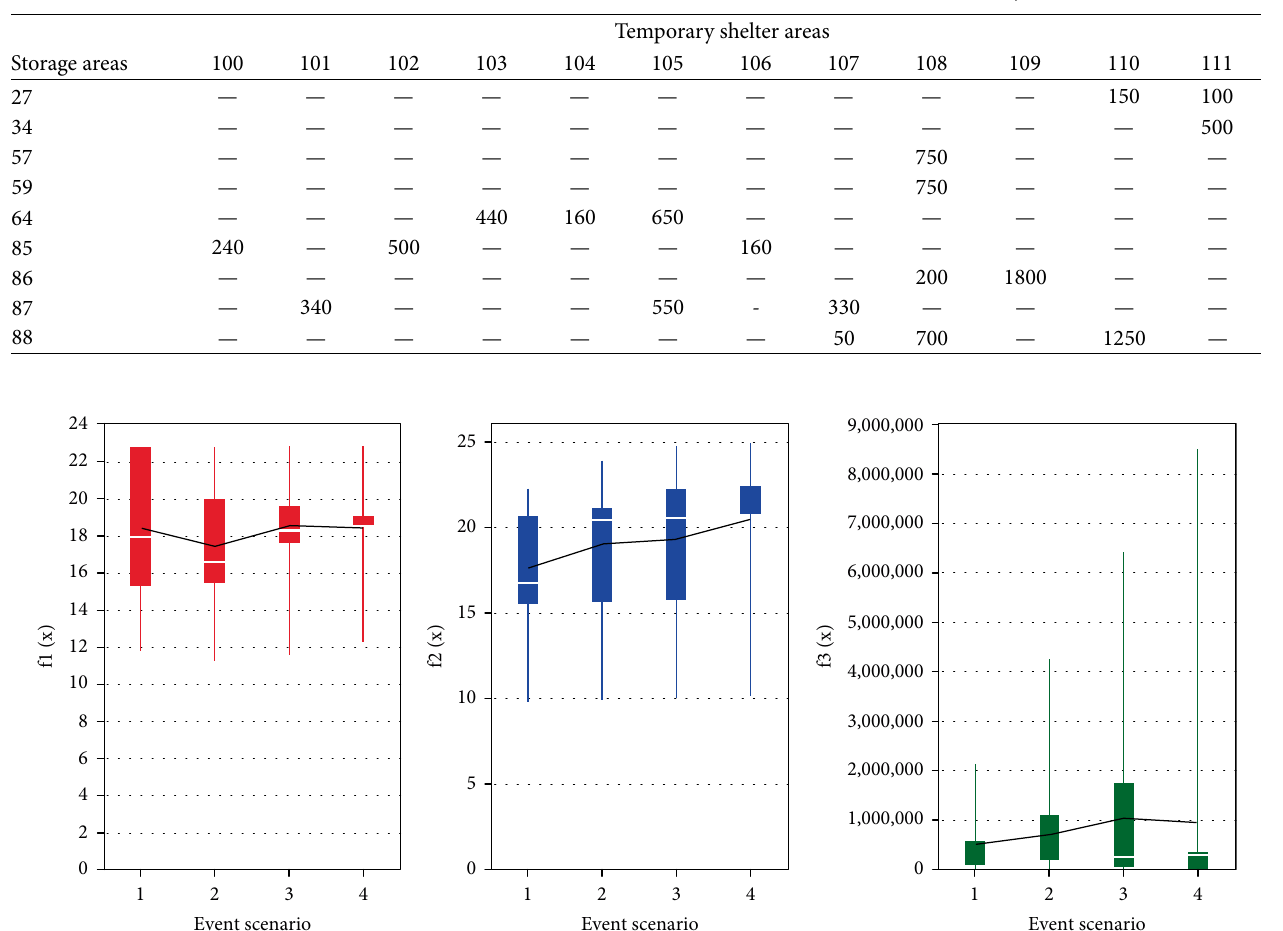
Table 9: Expected distribution plan of 10 th solution of scenario 3 if model C occurs (